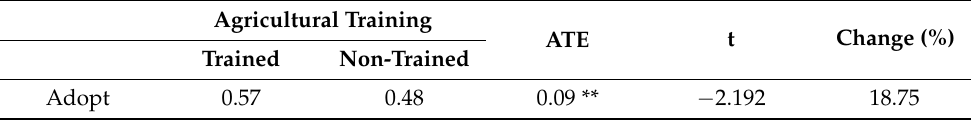
Table 10. The average treatment effect of agricultural training on the banana farmers’ adoption of the